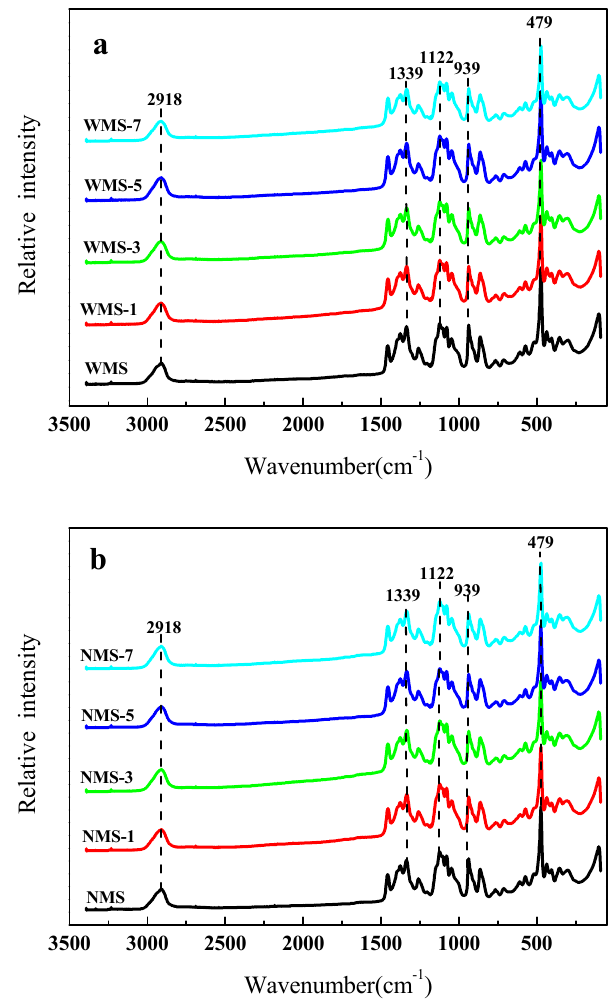
Figure 6. Raman spectra of maize starch samples treated by APPJ. ( a ) Waxy maize starch ( b ), normal maize starch.